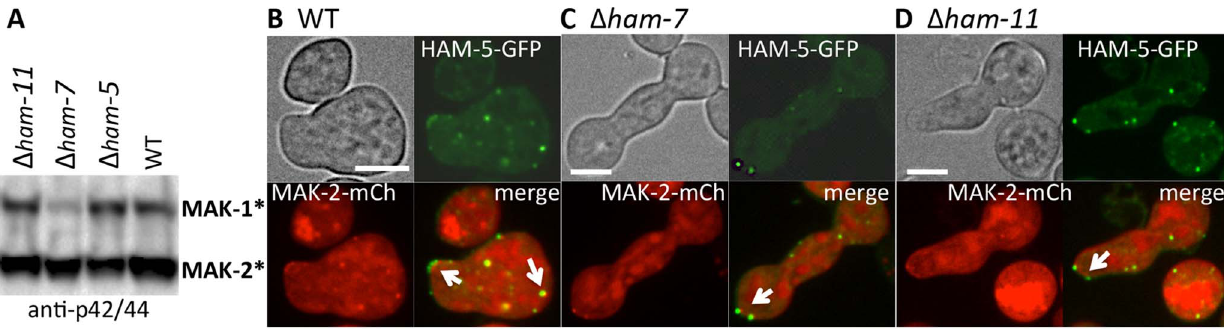
Figure 6. HAM-5-GFP and MAK-2-mCherry localize to puncta in D ham-7 and D ham-11 fusion-deficient germlings. (A) Western blot of protein samples from 5 hr-old WT, D ham-5 , D ham-7 and D ham-11 germlings probed with anti-p42/44 antibodies, which recognize phosphorylated MAK-1 and MAK-2 [8]. As previously shown [43], MAK-1 phosphorylation is reduced in the D ham-7 mutant. (B) HAM-5-GFP and MAK-2-mCherry localization in WT germlings undergoing chemotropic interactions. Arrows show localization to the CAT tip and to cytoplasmic puncta. (C) HAM-5- GFP and MAK-2-mCherry co-localization in D ham-7 ( ham-5-gfp; mak-2-mCherry ) germlings. Note lack of chemotropic interactions. Arrows show puncta of HAM-5-GFP and MAK-2-mCherry in D ham-7 ( ham-5-gfp; mak-2-mCherry ) germlings, which are often co-localized at the germ tube tip. (D) HAM-5-GFP and MAK-2-mCherry co-localization in D ham-11 ( ham-5-gfp; mak-2-mCherry ) germlings. Note lack of chemotropic interactions. HAM-5- GFP and MAK-2-mCherry co-localized to both cytoplasmic and tip-localized puncta (arrows). The upper left panels are bright field images, the upper right panels show GFP fluorescence, the lower left panels show mCherry fluorescence. Lower right panels show merged images of GFP and mCherry images. Scale bars =10 m M.